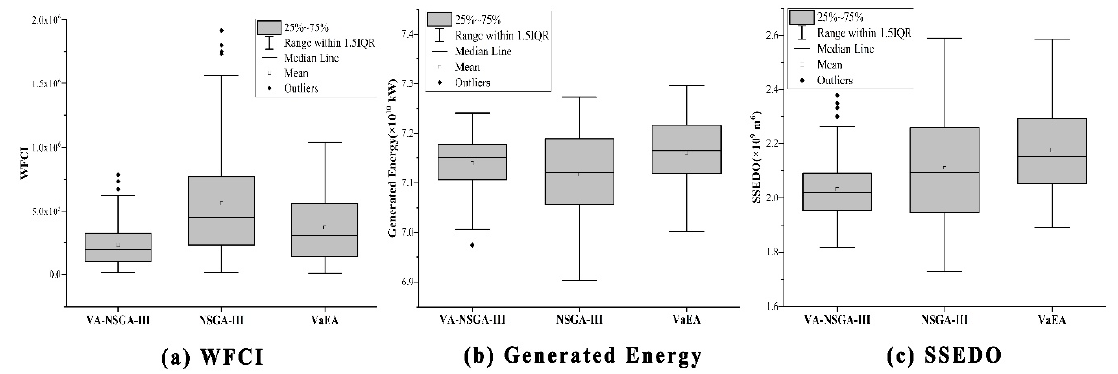
Figure 5. The box plot of each Pareto frontier target value of the three algorithms.